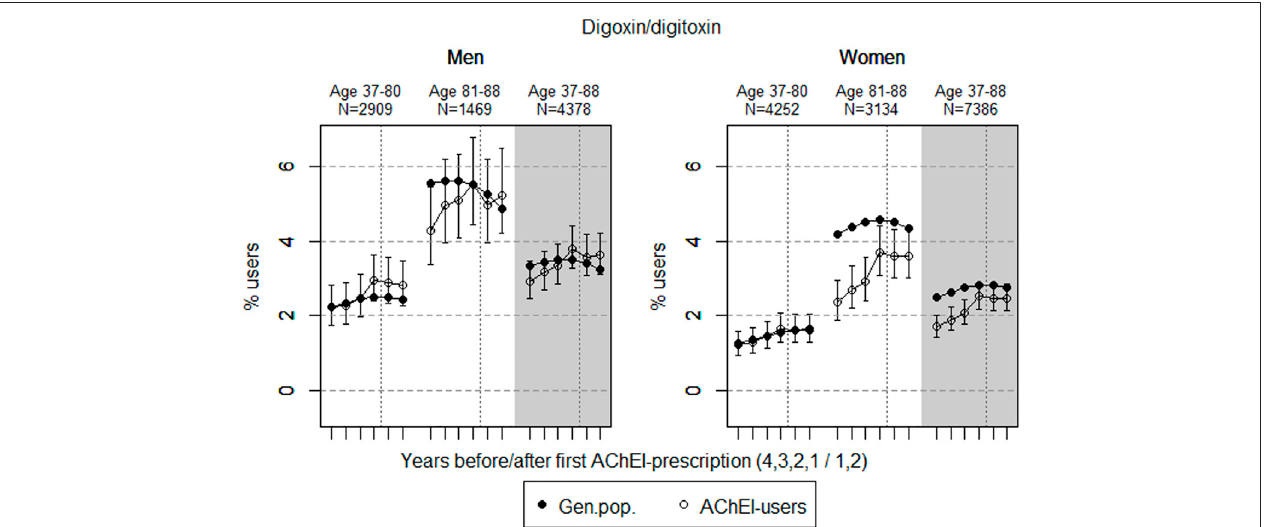
FIGURE5| Opencircles:Proportionofmenandwomen,respectively,ofthestudypopulationwho fi lledatleastoneprescriptionofdigoxinordigitoxin(ATCC01A) in the 4 years before AChEI initiation and the 2 years after with 95% con fi dence intervals. Bullets: The corresponding age adjusted proportion in the general population. Dashed vertical lines indicate AChEI initiation. The size of each age group in the study population is given on top.